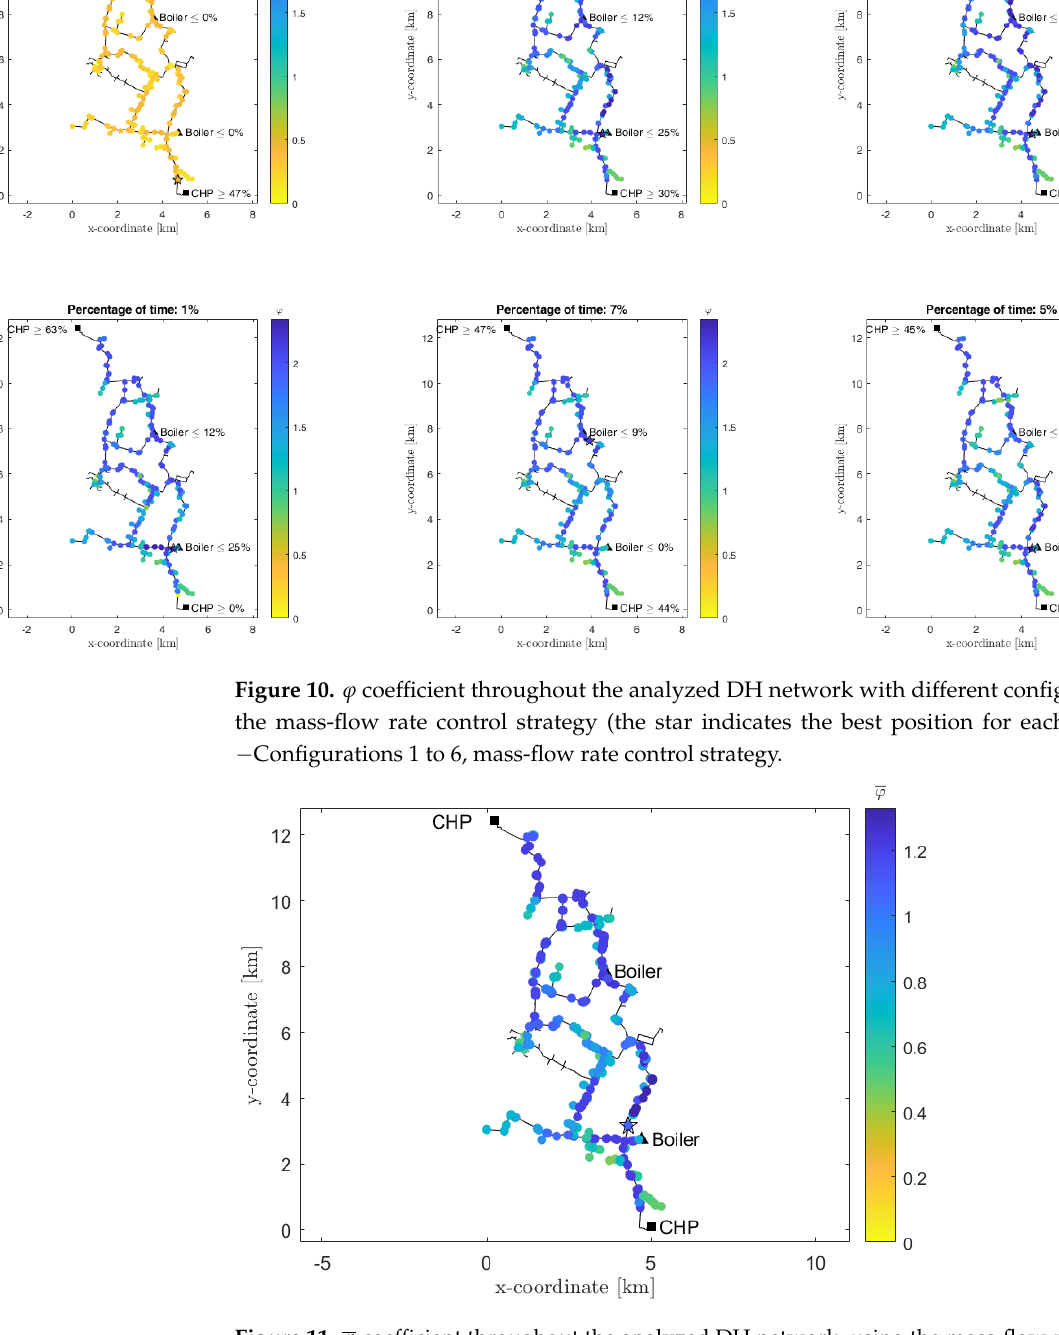
Figure 11. ϕ coefficient throughout the analyzed DH network, using the mass-flow rate control strat- egy (the star indicates the best position) − Average yearly operation, mass-flow rate control